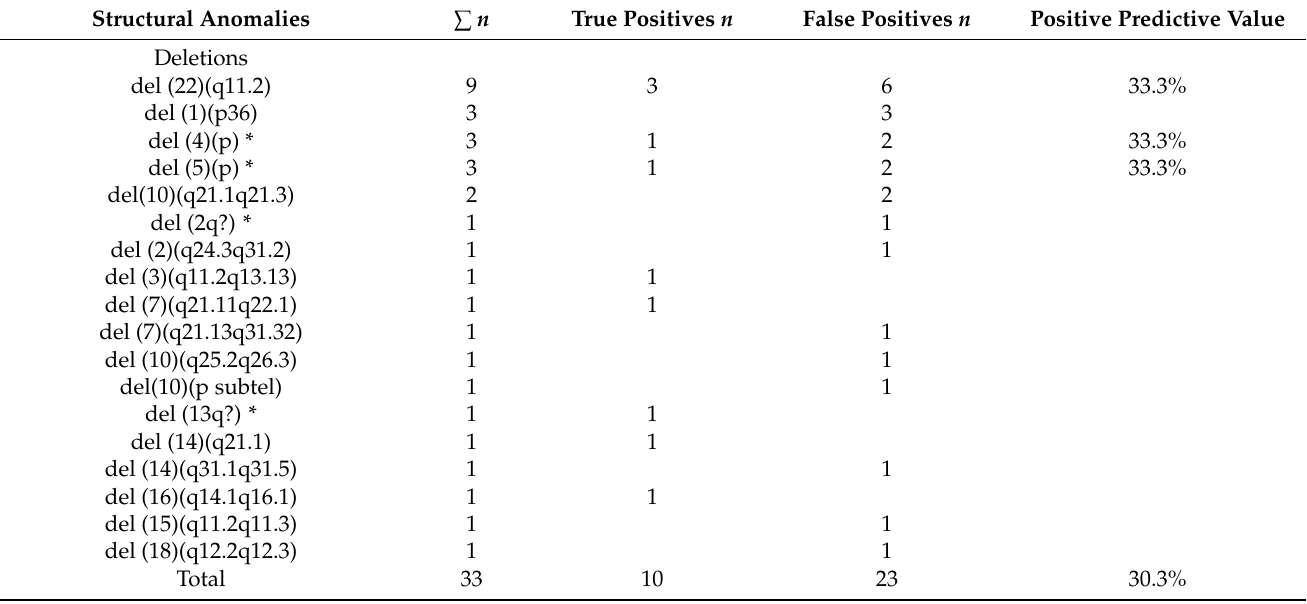
Table 2. The outcomes of the cases with a positive cfDNA test result for structural chromosome anomalies. Structural Anomalies ∑ n True Positives n False Positives n Positive Predictive